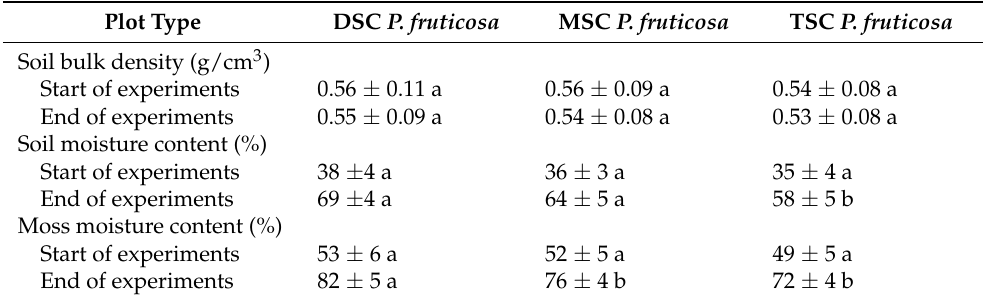
Table 3. Soil bulk density, soil moisture content, and moss moisture content in lysimeters at the start and end of experiments on different shrub